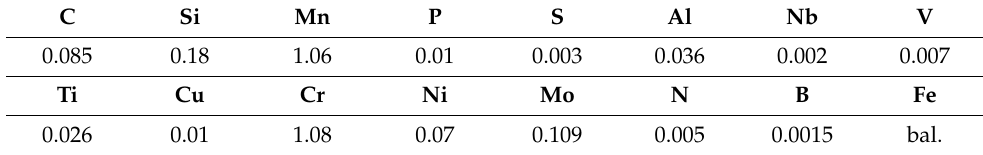
Table 2. Chemical composition of Strenx 960MC according to the inspection certificate